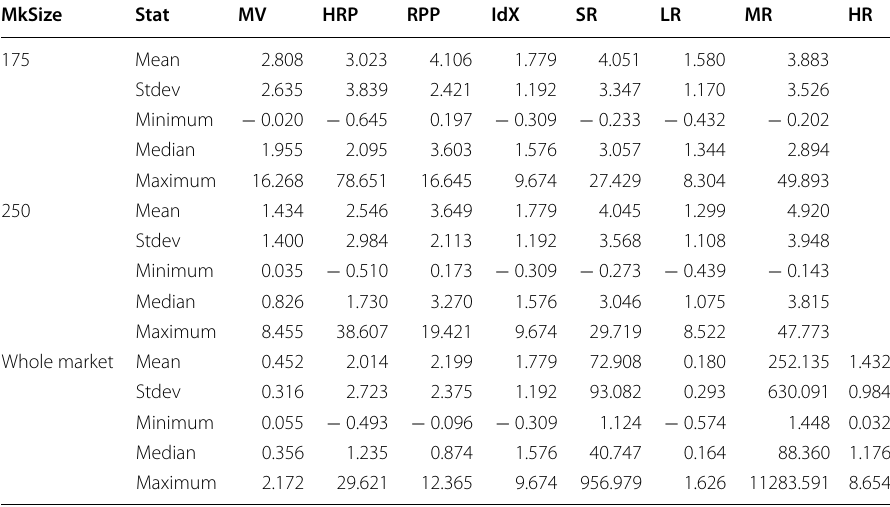
Table 5 Annualized returns ( r ann G ) of the simulations (1500 random investing paths) for the different strategies and market sizes MkSize Stat 175